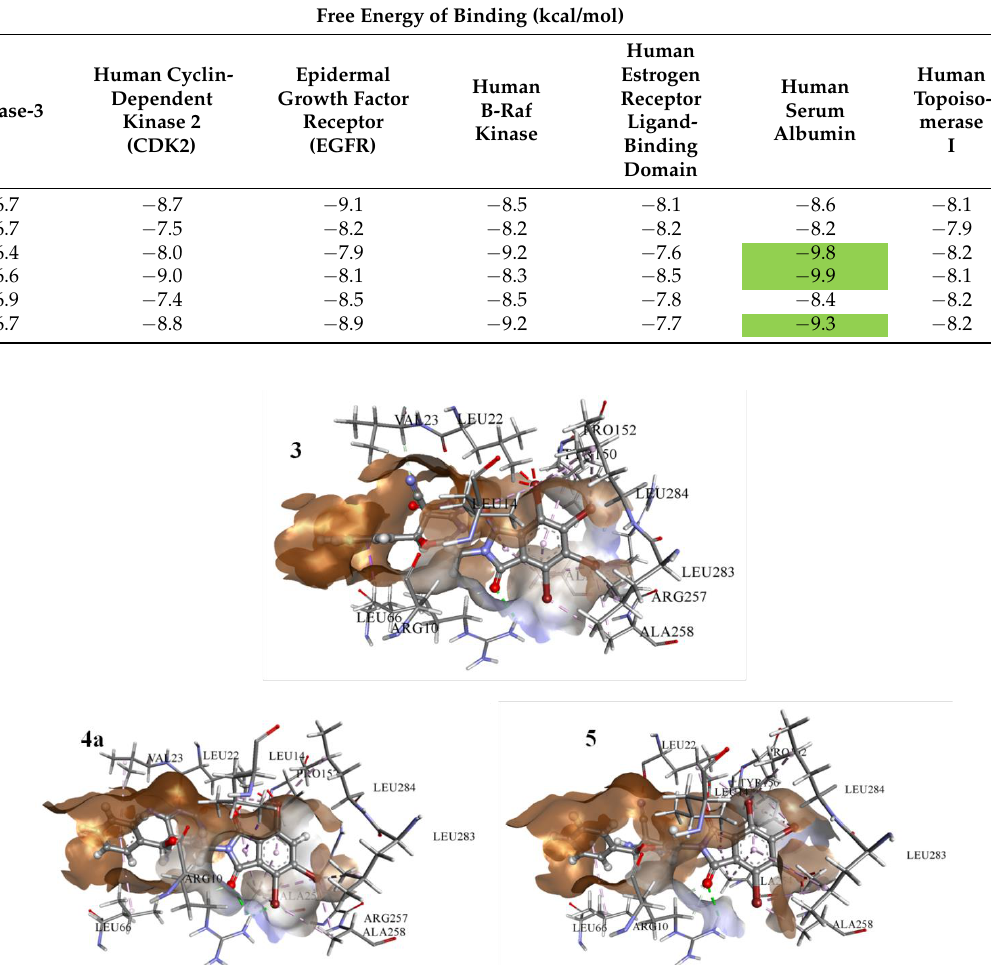
Table 12. List of virtual screening-based parameters for the selected drug targets against the studied anticancer inhibitors (green color selected for MD simulations).